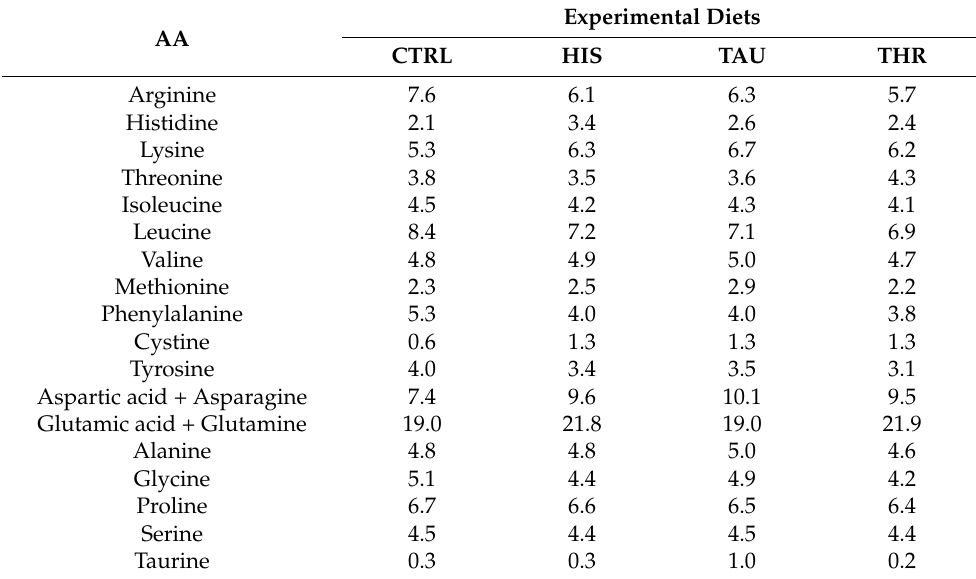
Table 2. Amino acid (AA) composition (g AA 100 g − 1 CP) of the experimental